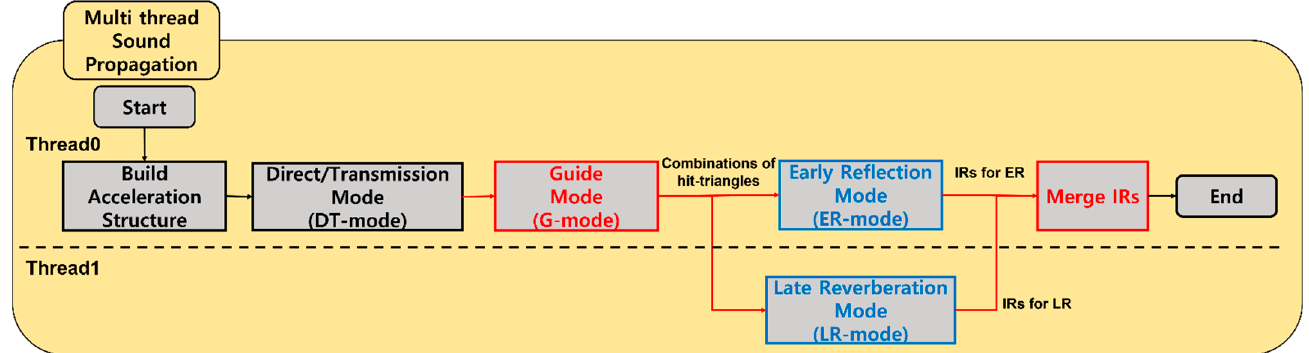
Figure 6. Proposed multi-threaded sound propagation algorithm: new stages (red boxes), modified stages (blue boxes).